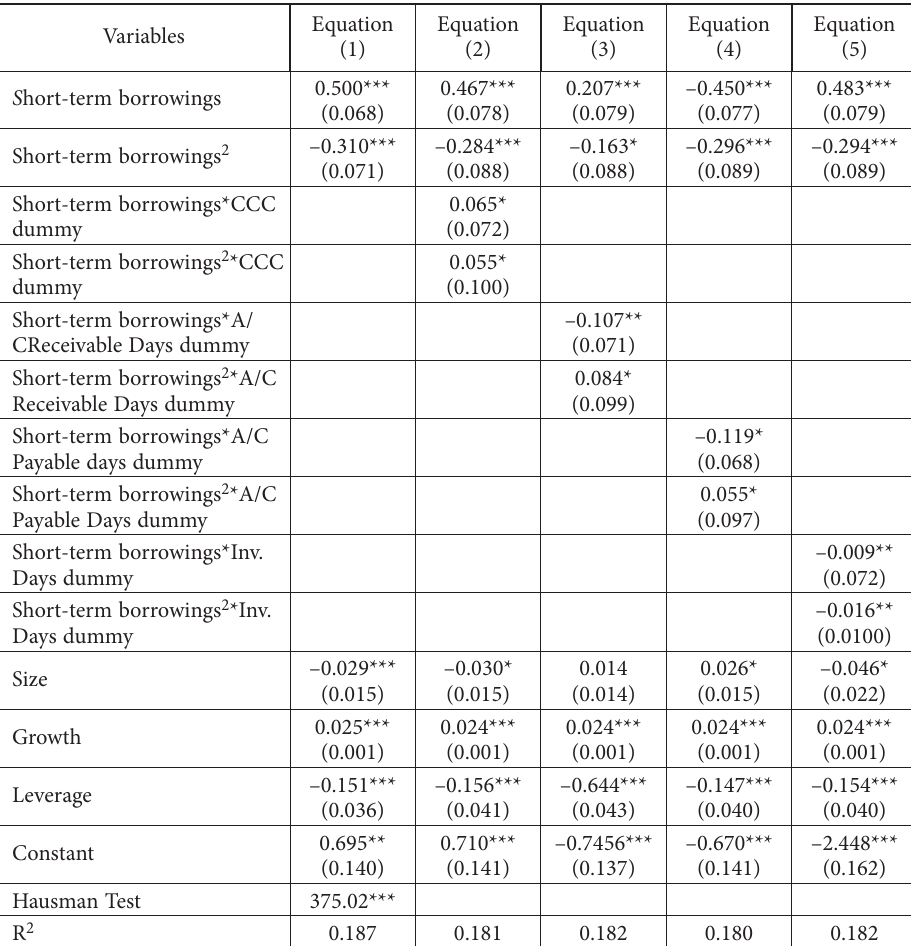
Table 8. Short-term borrowings and Profitability relation estimation using the fixed-effect model for firms under the moderating role of CCC and its components Variables